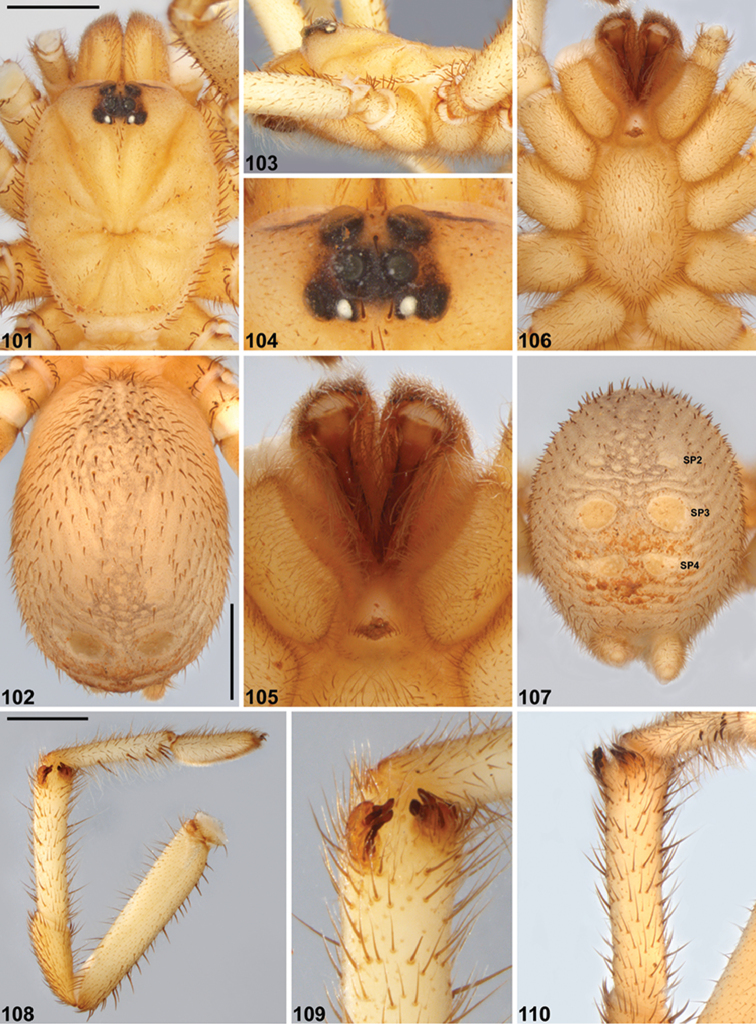

Idiosoma
corrugatum sp. n., male holotype (SAM NN29858) from SW. of Kimba (South Australia; EYB), somatic morphology. 101–102 Carapace and abdomen, dorsal view 103 Carapace, lateral view 104 Eyes, dorsal view 105 Mouthparts, ventral view 106 Sternum, ventral view 107 Abdomen, posterior view 108 Leg I, prolateral view 109 Leg I tibia, clasping spurs, prolateral view 110 Leg I tibia, proventral view. Scale bars 2.0. SP2–4 = sigilla pairs 2–4.